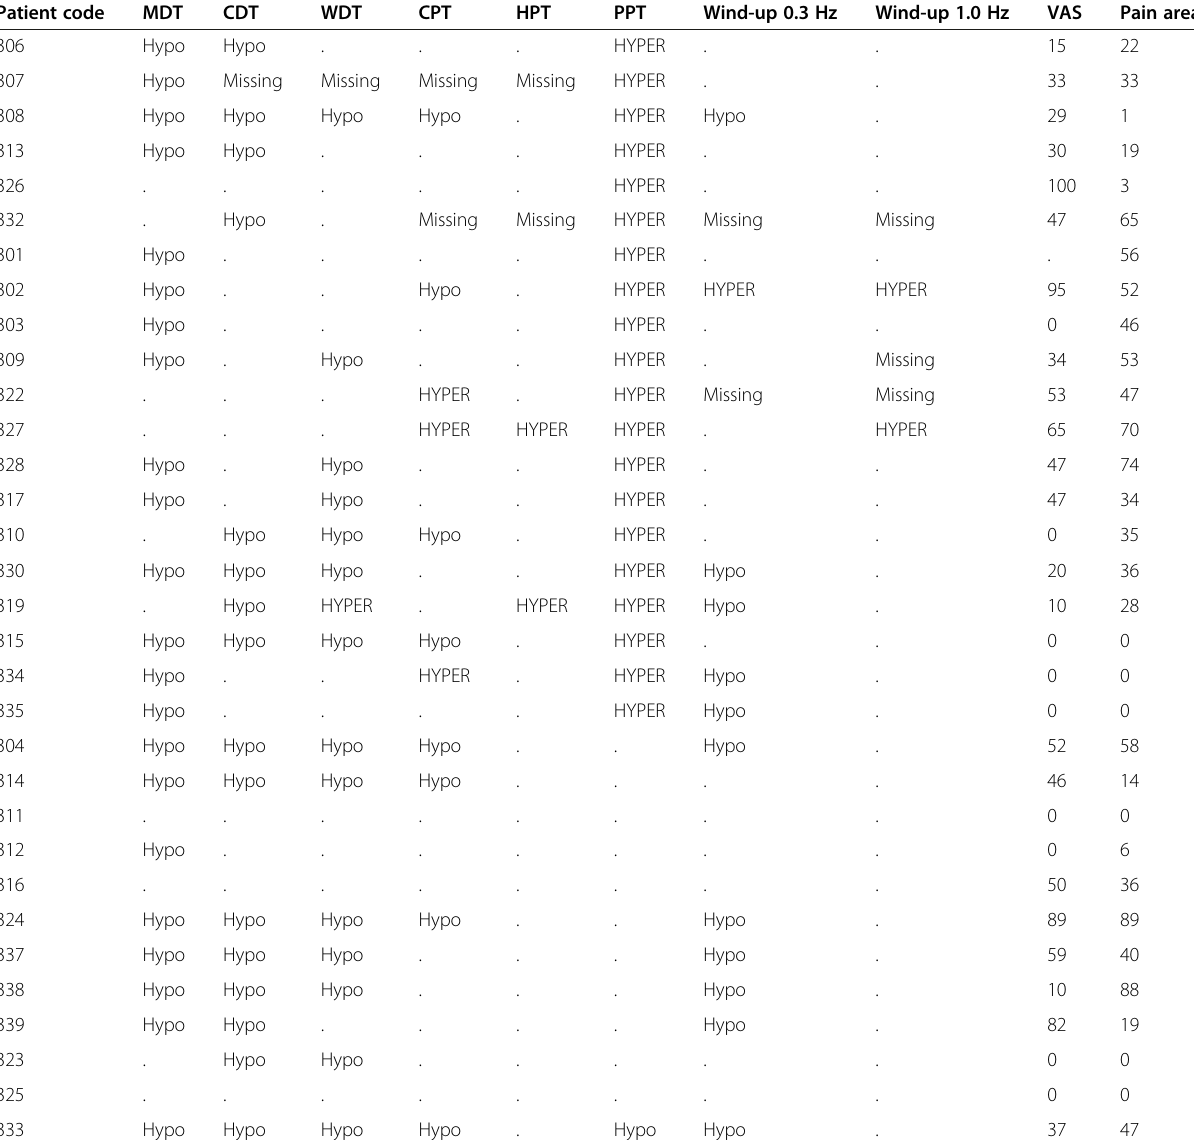
Table 4 Categorized sensory function from QST data (hypo, normal=blank space, HYPER; see text), current pain intensity and pain area sorted by ‘ PPT, pain when walking and type of foot pain ’ in the left foot sole of 32 torture victims Patient